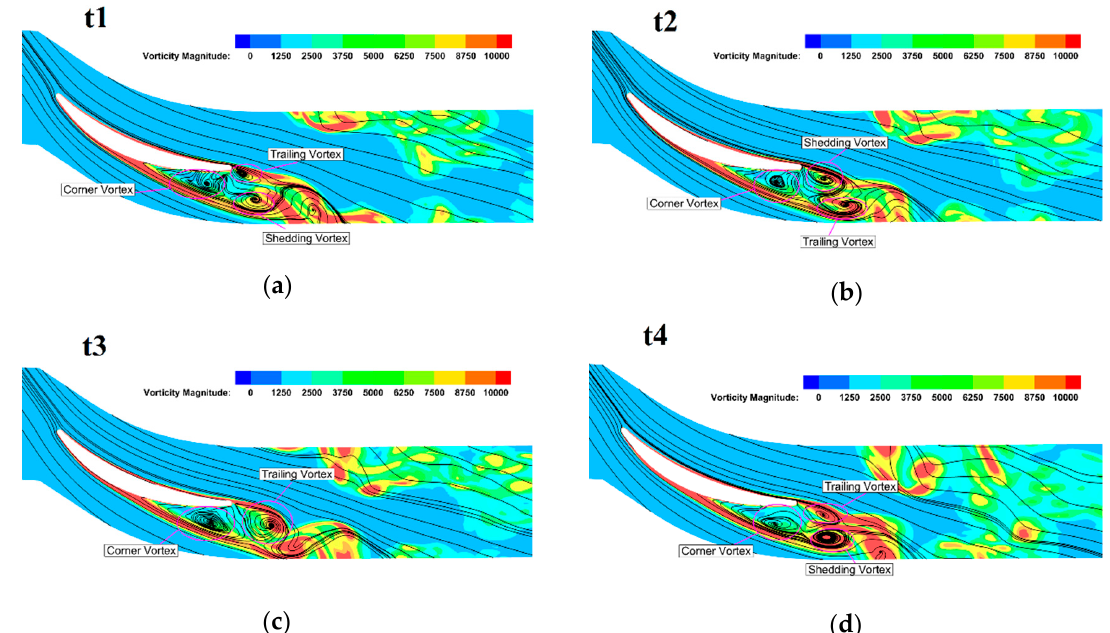
Figure 8. Streamlines at 20% span at different times: ( a ) t1; ( b ) t2; ( c ) t3; ( d ) t4.